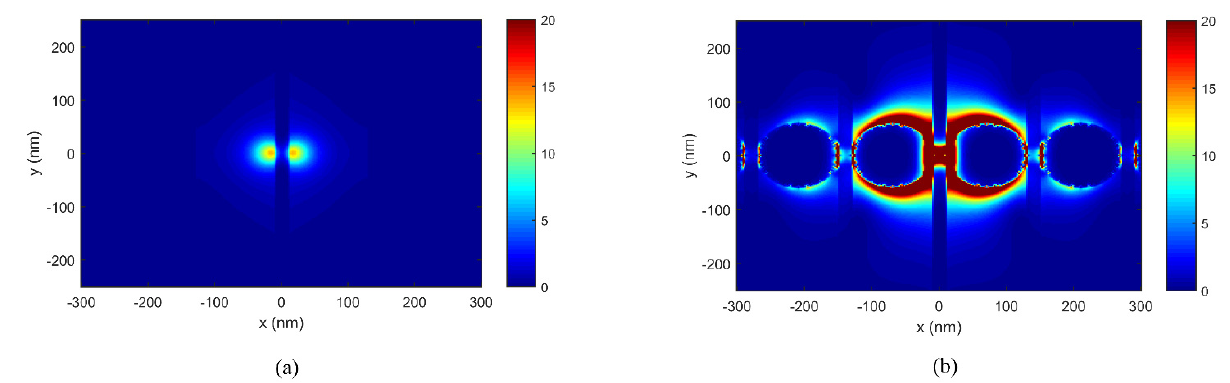
Figure 7. Electric field distributions for ( a ) nanopillar and ( b ) Al nanosphere structure DUV-LEDs with nanopillar height being 230 nm.